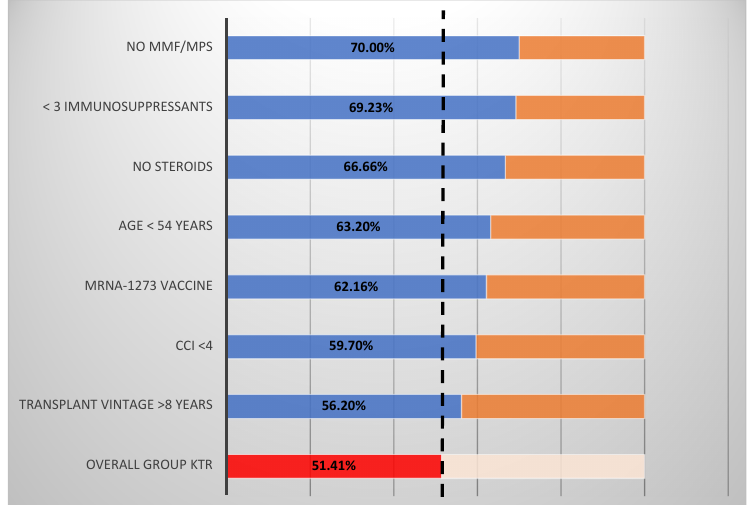
Figure 2. Strata analyses of anti-s IgG seroconversion rate in the study group. Legend: MMF/MPS, mycophenolate mofetil/Na; CCI; Charlson comorbidity index; KTR, kidney transplant recipients. Seroconversion rate (blue/red columns). Seroconversion in complimentary strata were as follows: MMF/MPS + (46.4%); <3 immunosuppressants (44.6%); steroids + (50%); age > 54 (39.1%); BNT162b2 + (47.6%); CCI > 4 (49.1%); transplantation vintage < 8 years (39.1%). 3.3. Determinants of The Seroconversion in Anti-s IgG Antibodies in KTR The use of more than two immunosuppressive agents ( p = 0.009), treatment with MMF/MPS ( p = 0.02), shorter transplantation vintage ( p = 0.002), and older age ( p = 0.002) were predictors of no response to the vaccine in univariable analysis, and were therefore retained in the multivariable logistic regression model along with the variables for which the trend of association with the seroconversion was shown: CCI, induction treatment in history, serum creatinine level, and type of vaccine (Table 2). Table 2. Univariable analysis of predictors for anti-s IgG seroconversion.